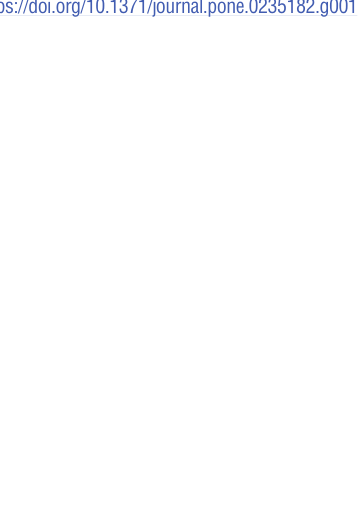
PLOS ONE | https://doi.org/10.1371/journal.pone.0235182 August 9,